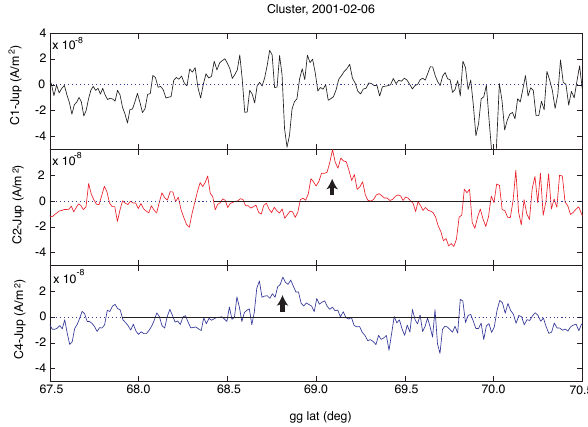
Fig. 9. As Fig. 3, but now for the poleward arc and using T89c K p =5. The times corresponding to arrows from top to bottom are: 23:36:30 UT and 23:37:40